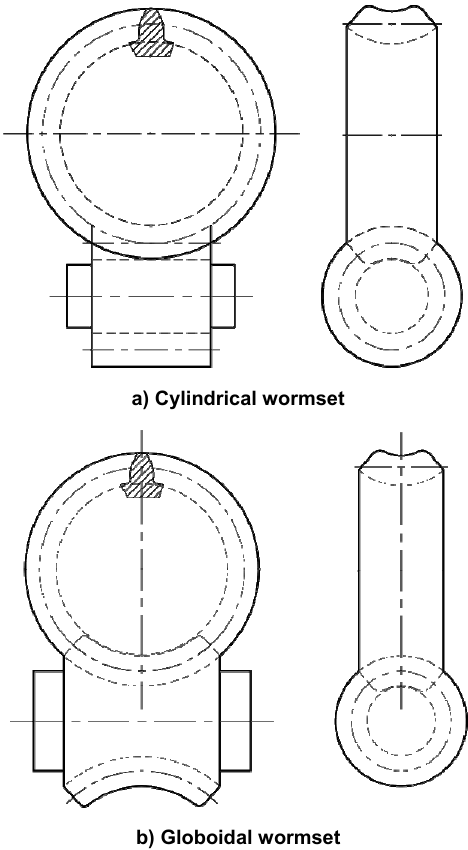
Fig. 1: Types of worm